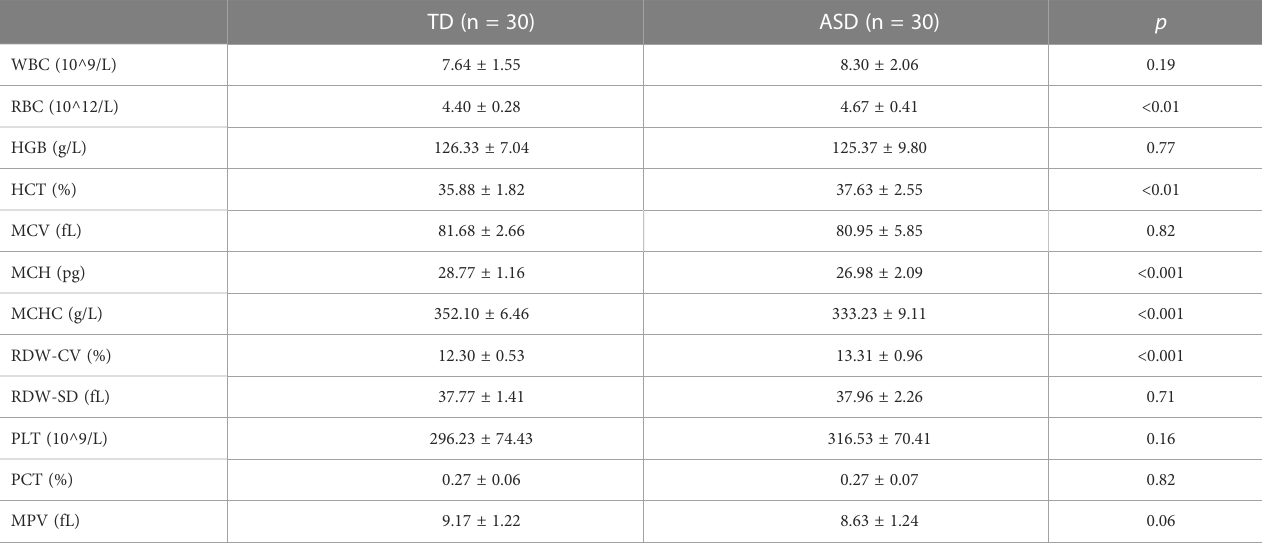
TABLE 2 The comparison of routine blood tests between TD and ASD groups in the clinical children ’ s